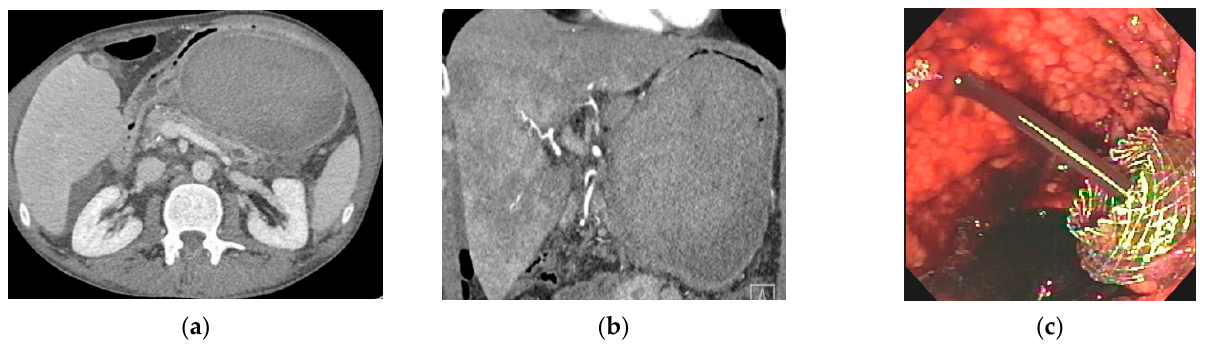
Figure 3. CT and endoscopic image of a hemorrhagic pseudocyst. ( a ) Sagittal CT imaging of pseudocyst with heterogenous material consistent with hemorrhage; ( b ) coronal CT imaging of hemorrhagic pseudocyst prior to LAMS placement; and ( c ) endoscopic imaging post-LAMS placement with blood tinged fluid draining in the stomach.